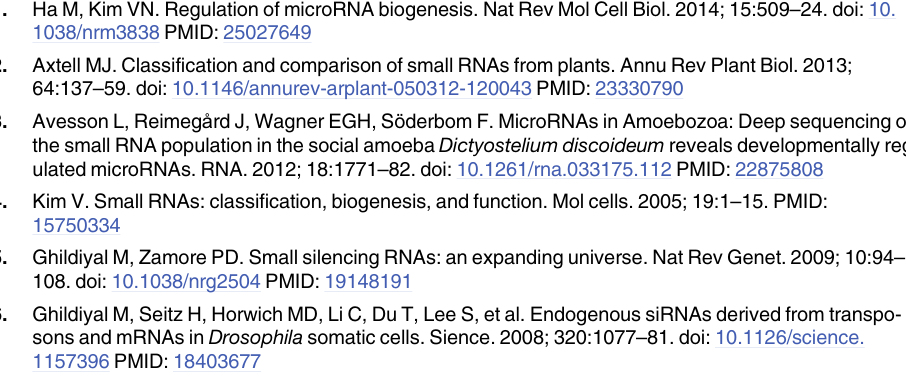
S1 Table. Detailed list of predicted milRNA target sites. S2 Table. Strains used in this study. S3 Table. Cultivations used for RNA-Seq samples. (XLSX) S4 Table. Components involved in small RNA biogenesis of Penicillium chrysogenum com- pared to five other fungi. S5 Table. List of plasmids used in this study. (XLSX) S6 Table. List of oligonucleotides used in this study.